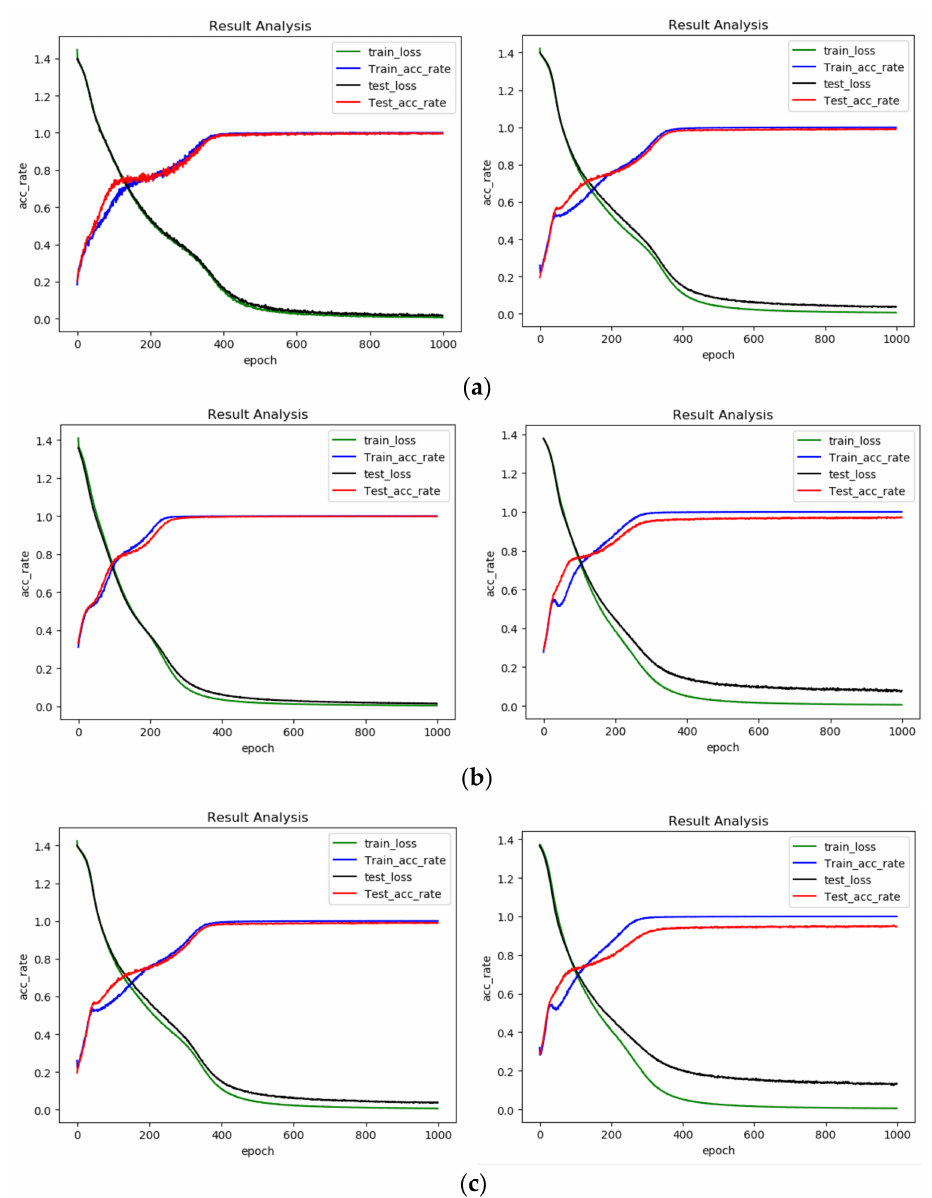
Figure 10. Diagnosis results of each dataset. ( a ) Diagnosis results of dataset A (the former is OT- 1DCNN, the latter is DCNN); ( b ) diagnosis results of dataset B (the former is OT-1DCNN, the latter is DCNN); ( c ) diagnosis results of dataset C (the former is OT-1DCNN, the latter is